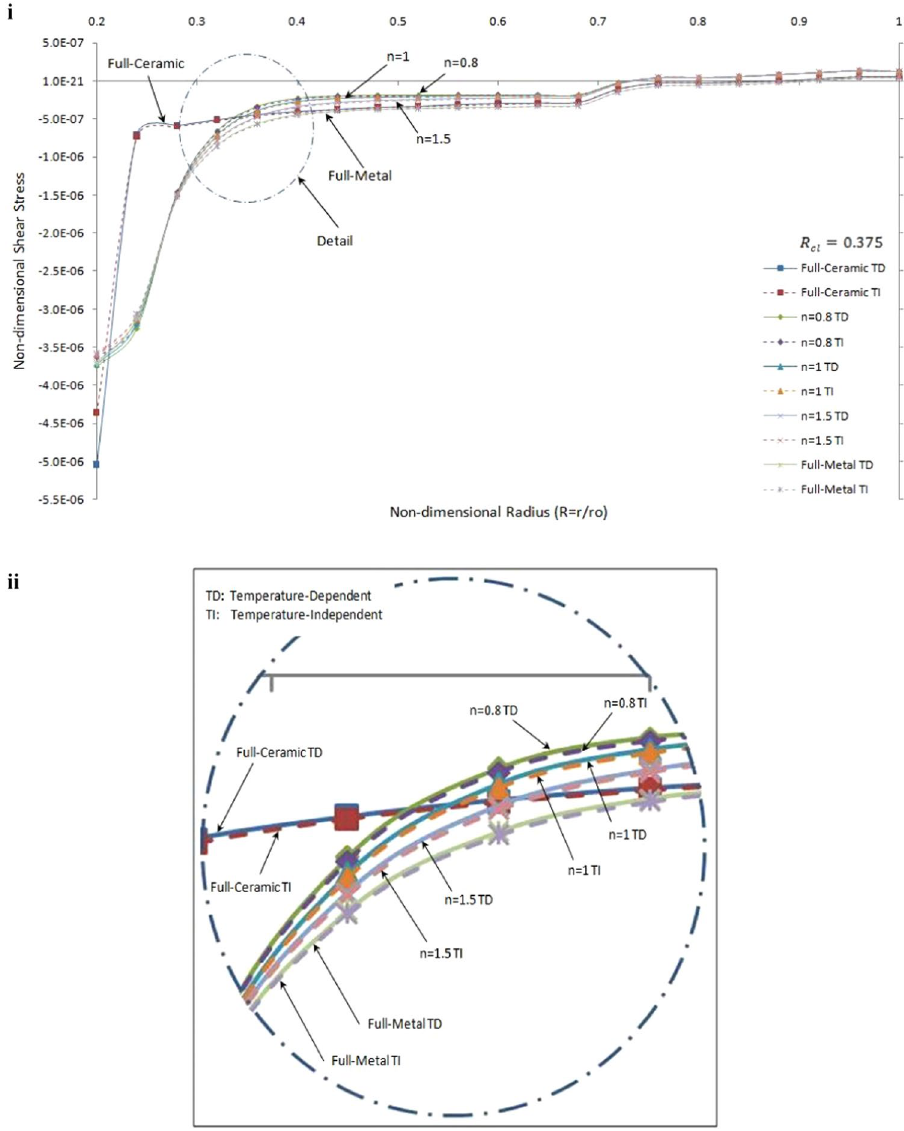
Figure 10. Non-dimensional shear stress versus the non-dimensional radius of one side contact with temperature-dependent and temperature-independent material properties under Rcl = 0.375 and different values of the grading index, n. (ii) detail of part